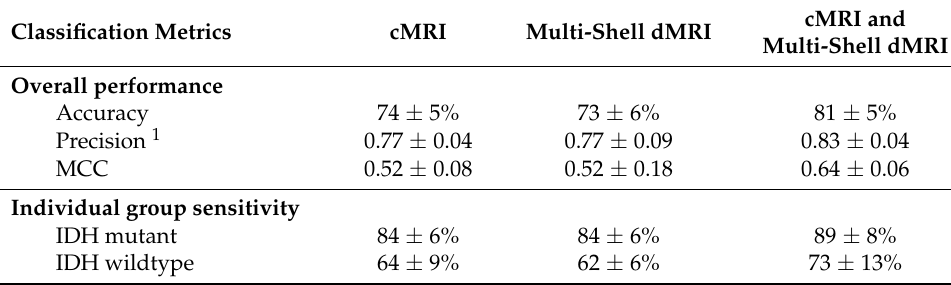
Table 5. IDH status classification performances in adult-type gliomas (WHO CNS5). Classification Metrics